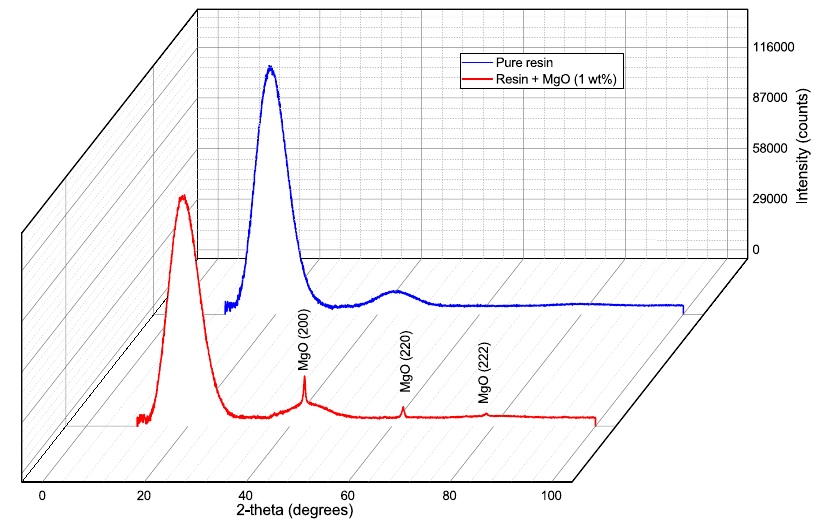
Figure 5. X-ray diffraction pattern of investigated materials.